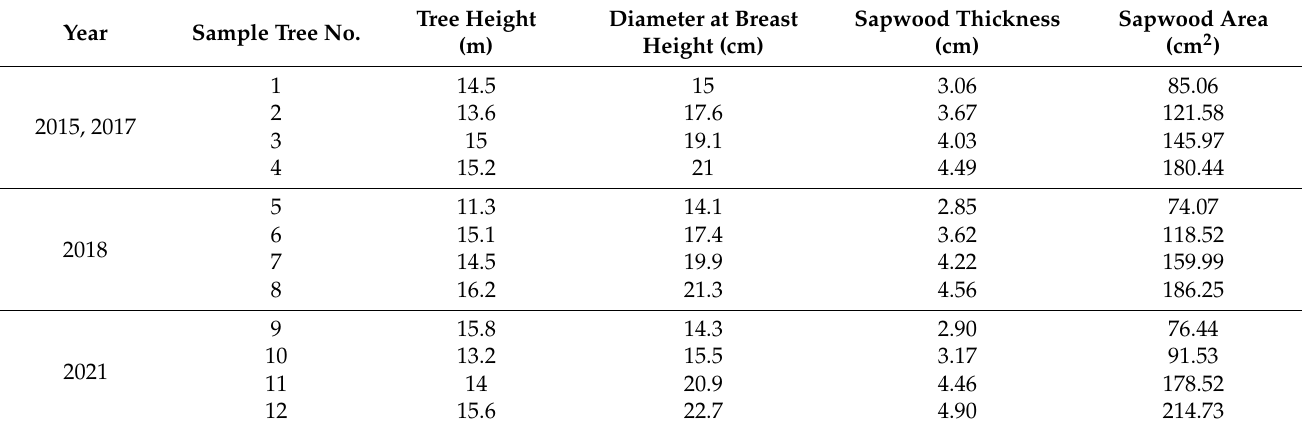
Table 1. Characteristics of sample trees selected for the measurement of sap flow. Year Sample Tree